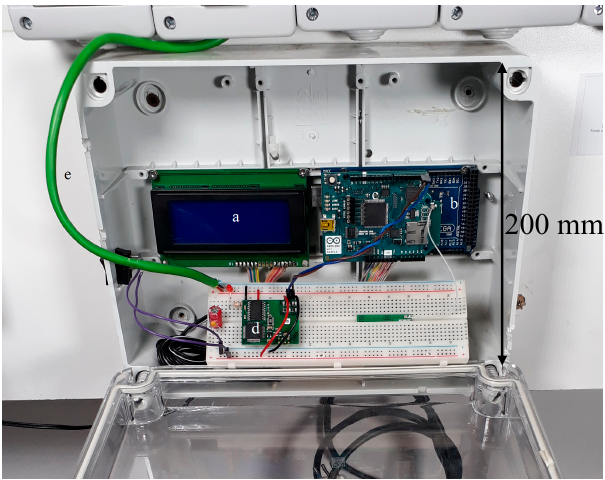
Figure 13. The low-EB prototype and ( a ) the liquid crystal display (LCD); ( b ) the Arduino Mega 2560; ( c ) the WIFI shield; ( d ) the sim Tapko and ( e ) the shielded twisted pair (STP) cable.